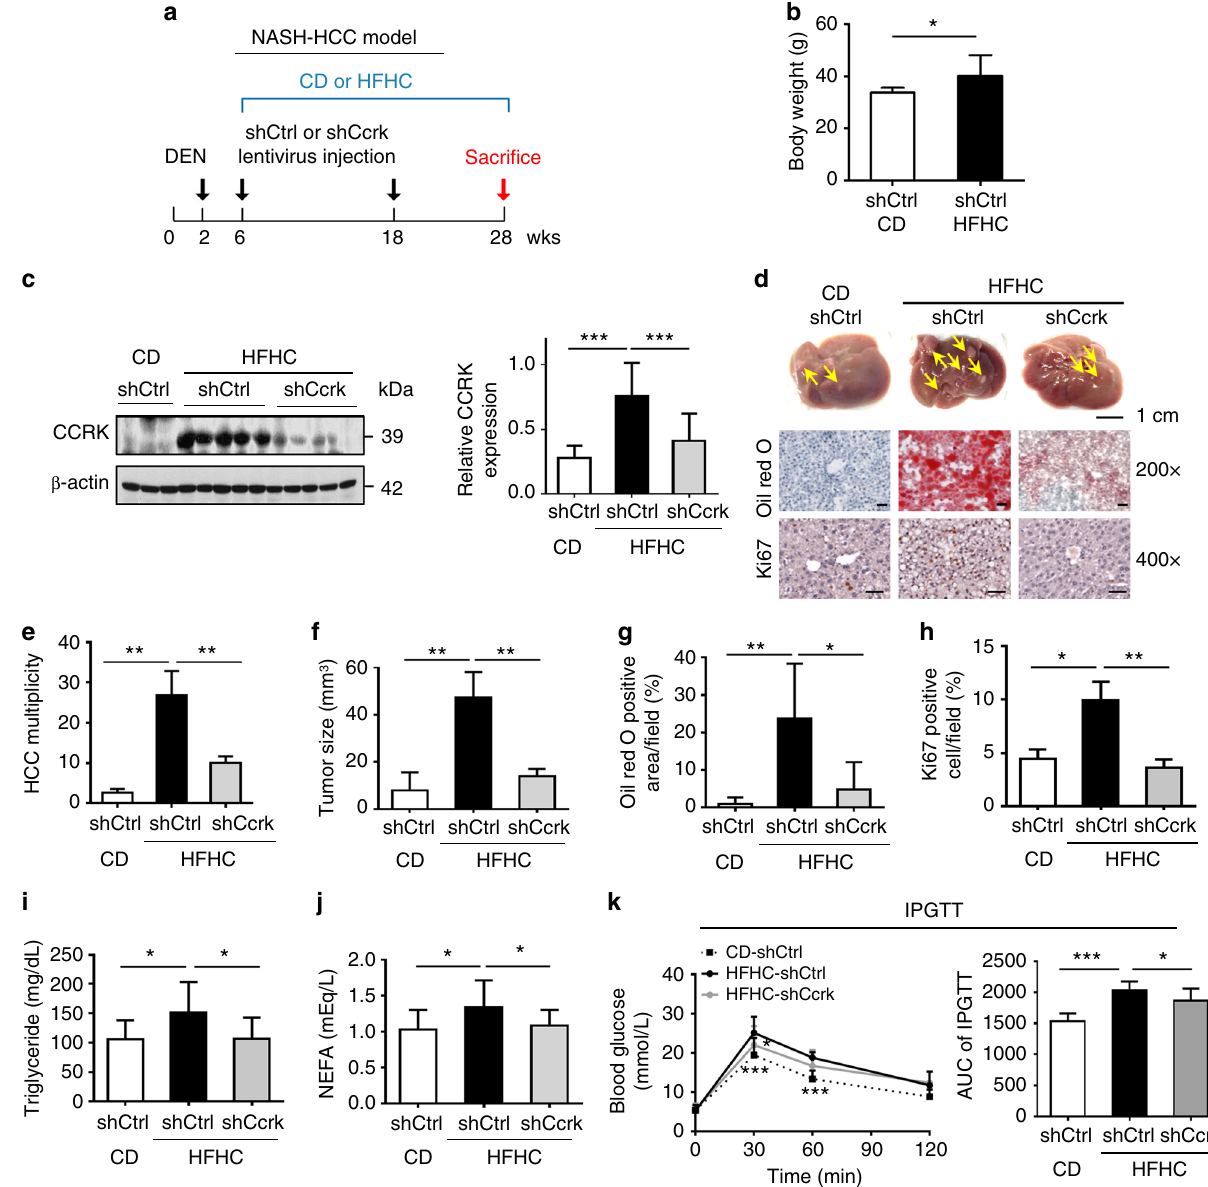
Fig. 2 Knockdown of Ccrk improves glucose sensitivity, and reduces hepatic lipid accumulation and hepatocarcinogenesis. a Schematic diagram of NASH- HCC mouse model with carcinogen induction (DEN diethylnitrosamine), different diets, and lentivirus-mediated Ccrk knockdown (CD + shCtrl, n = 8; HFHC + shCtrl, n = 15; HFHC + shCcrk, n = 15). b Body weight of mice at 28 weeks. c CCRK protein expression in mouse livers were increased by HFHC at 28 weeks, which could be reduced by shRNA-mediated knockdown. Quanti fi cation of CCRK protein levels (relative to β -actin) is shown in a bar chart (right). d Representative pictures of dissected livers (scale bar = 1 cm), and Oil Red O and Ki67 staining of liver tissues in different groups (image magni fi cation = ×200 or ×400, scale bar = 20 μ m). e Tumor multiplicity and f tumor sizes were higher in the livers of HFHC-fed mice, which could be reduced by Ccrk knockdown. g , h Dietary obesity-induced CCRK increased lipid accumulation and cell proliferation, which could be abrogated by Ccrk knockdown as shown by Oil Red O staining and Ki67 staining in the livers. i , j Blood triglyceride and NEFA levels were elevated by dietary obesity-induced CCRK at 28 weeks, which could be reduced by Ccrk knockdown. k CCRK over-expression impaired insulin sensitivity in mice. IPGTT was performed on CD-fed and HFHC-fed mice, blood glucose was measured at indicated time points after glucose injection (left), and AUC is shown in a bar chart (right). Data are presented as mean ± SD. * p < 0.05; ** p < 0.01; and *** p < 0.001 as calculated by unpaired two-tailed Student ’ s t -test ( b ), one-way ANOVA followed by Bonferroni post-hoc test ( c , e – k ), and two-way ANOVA followed by Bonferroni post hoc test ( k